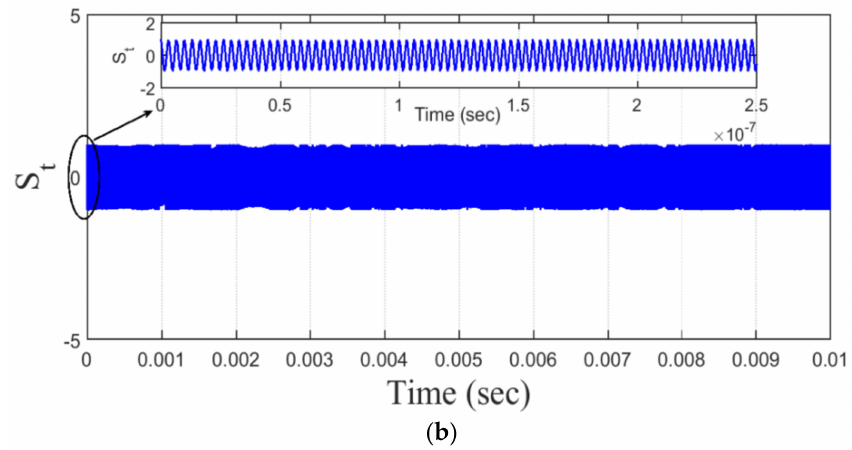
Figure 13. Monostatic continuous chaotic radar system for τ = 0.6 ms and x ( 0 ) = 0.5, a = 1,